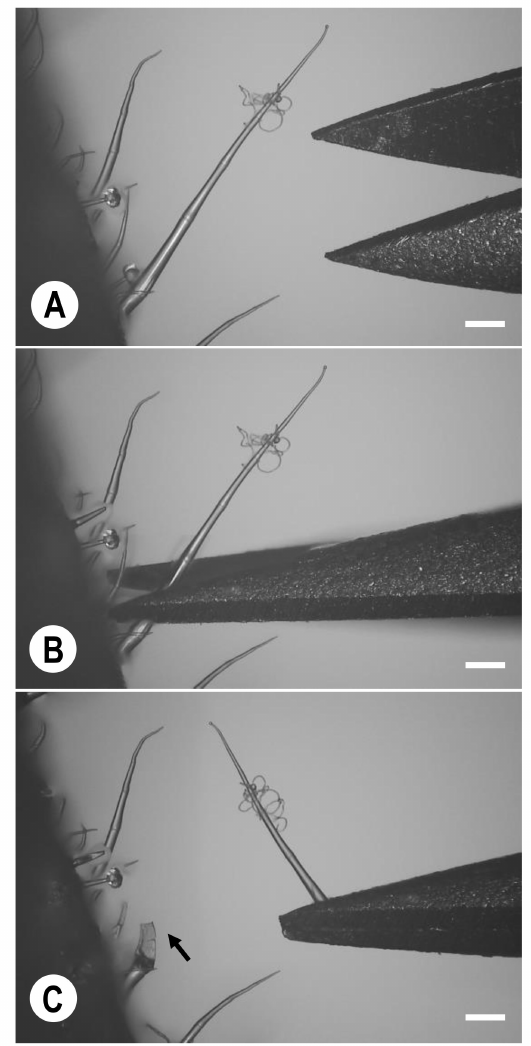
Figure 4. Procedure for the collection of single KTP-03-non-inoculated/inoculated leaf type I trichome cells of tomato cv. Moneymaker (MM). The basal cells of single trichomes were cut using small, pointed scissors (microscissors) installed in a micromanipulator. The microscissors were placed near the trichome basal cell ( A ) and directed towards that cell ( B ). Finally, the KTP-03-inoculated trichomes were cut using the microscissors held by the MSC-2 manipulator under a KH-2700 DM ( C ). Arrow in ( C ) indicates the location where a single trichome cell was successfully cut. Bars indicate 150 µ